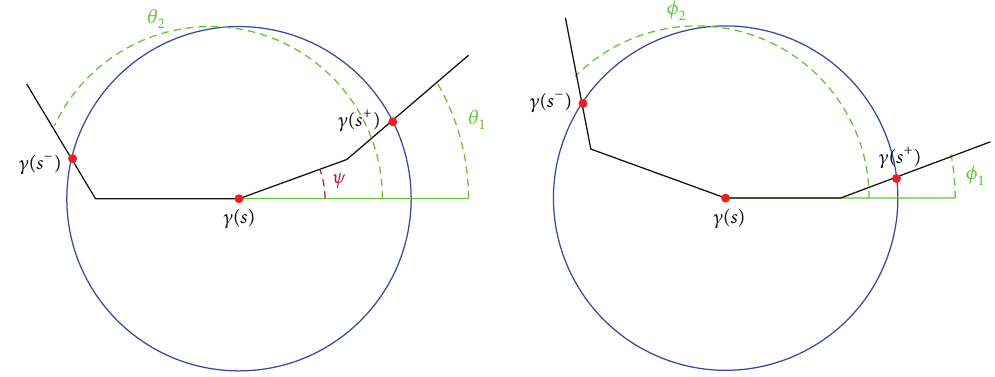
Figure 11: Using 𝑔 𝑠− and 𝑔 𝑠+ to obtain the polygon angle at 𝑠